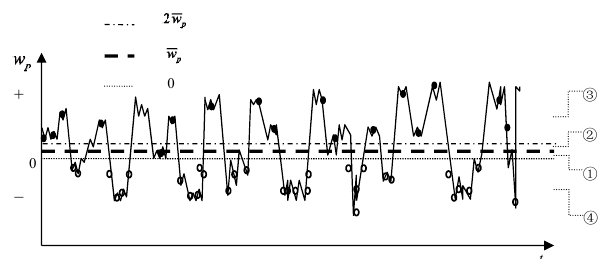
Figure 7. Illustration of the PDA data of particle velocity. Solid and open dots represent positive and negative w p measured by PDA, re- spectively, and the solid line w a + w t . As an example, suppose ¯ w p > 0, the full data set is divided into four parts: (1) 0 < w p < ¯ w p ; (2) ¯ w p < w p < 2 ¯ w p ; (3) w p > 2 ¯ w p ; and (4) ¯ w p <